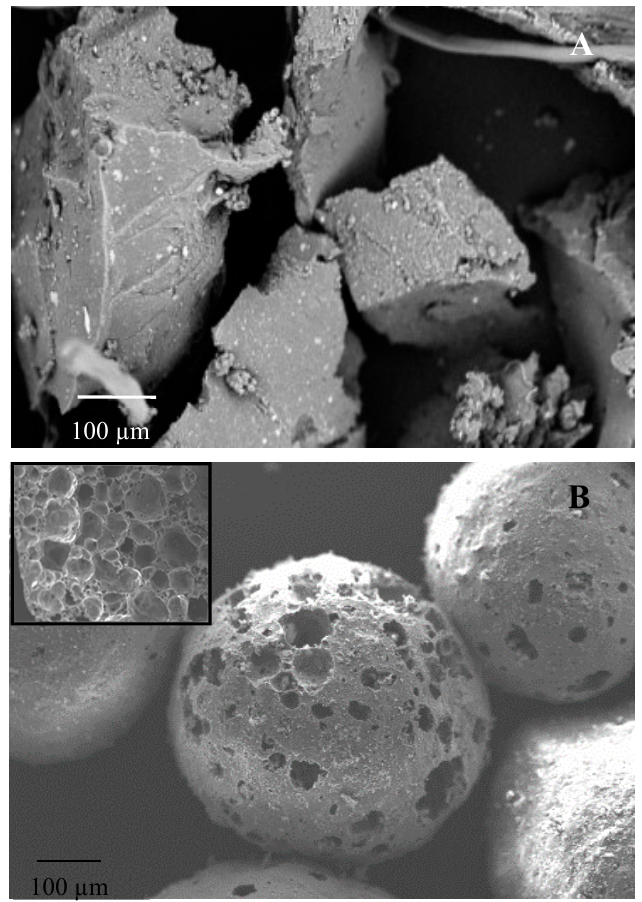
Figure 1. ( A ) Tyre rubber (TR) grain and ( B ) porous glass (PG) bead with evidenced porosity (in the inset: inner porosity).